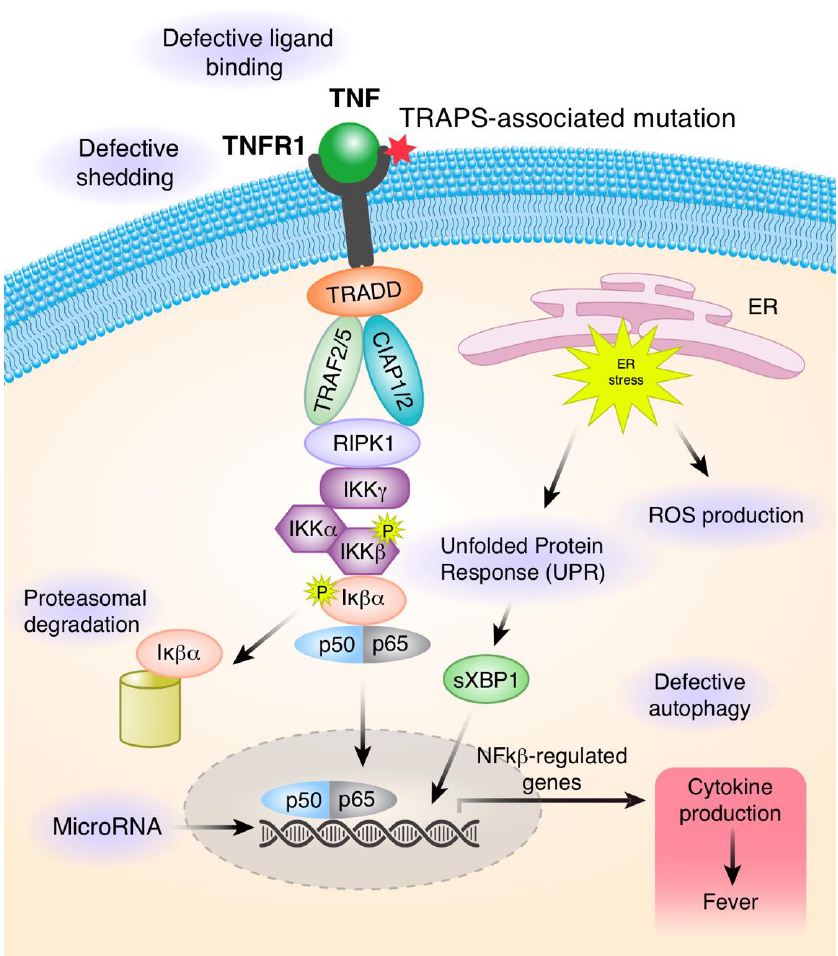
Figure 2. Summary of proposed pathogenic mechanisms in TRAPS. Binding of TNF α to TNFR1 leads to the assembly of the signaling pathway that ultimately upregulates the gene expression of many pro-inflammatory cytokines. There are multiple mechanisms that contribute to the pathogenesis of TRAPS. Heterozygous variants a ff ect the structure of the extracellular domain and impact its ability to bind to the TNF ligand. Mutant receptors fail to shed from the cell surface to generate soluble TNFR1 proteins, which function to attenuate signaling through the TNFR1 receptor. Mutated misfolded proteins accumulate in the cells and cause endoplasmic stress (ER), upregulation in the unfolded protein response (UPR), and increased production of mitochondrial reactive oxygen species (ROS). The UPR initiates ER membrane stress sensors, including inositol-requiring protein (IRE1) α , to restore